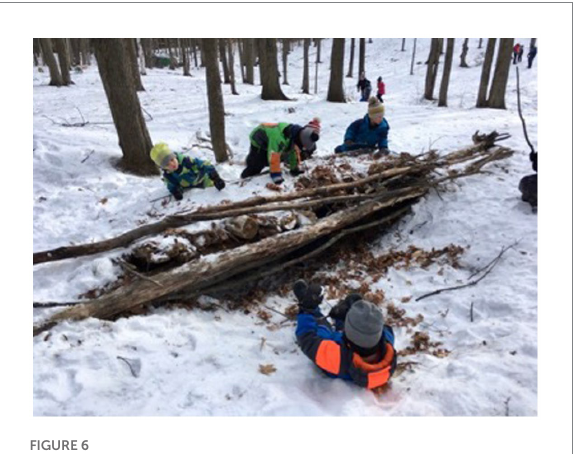
FIGURE 6 Students build a shelter as part of an outdoor